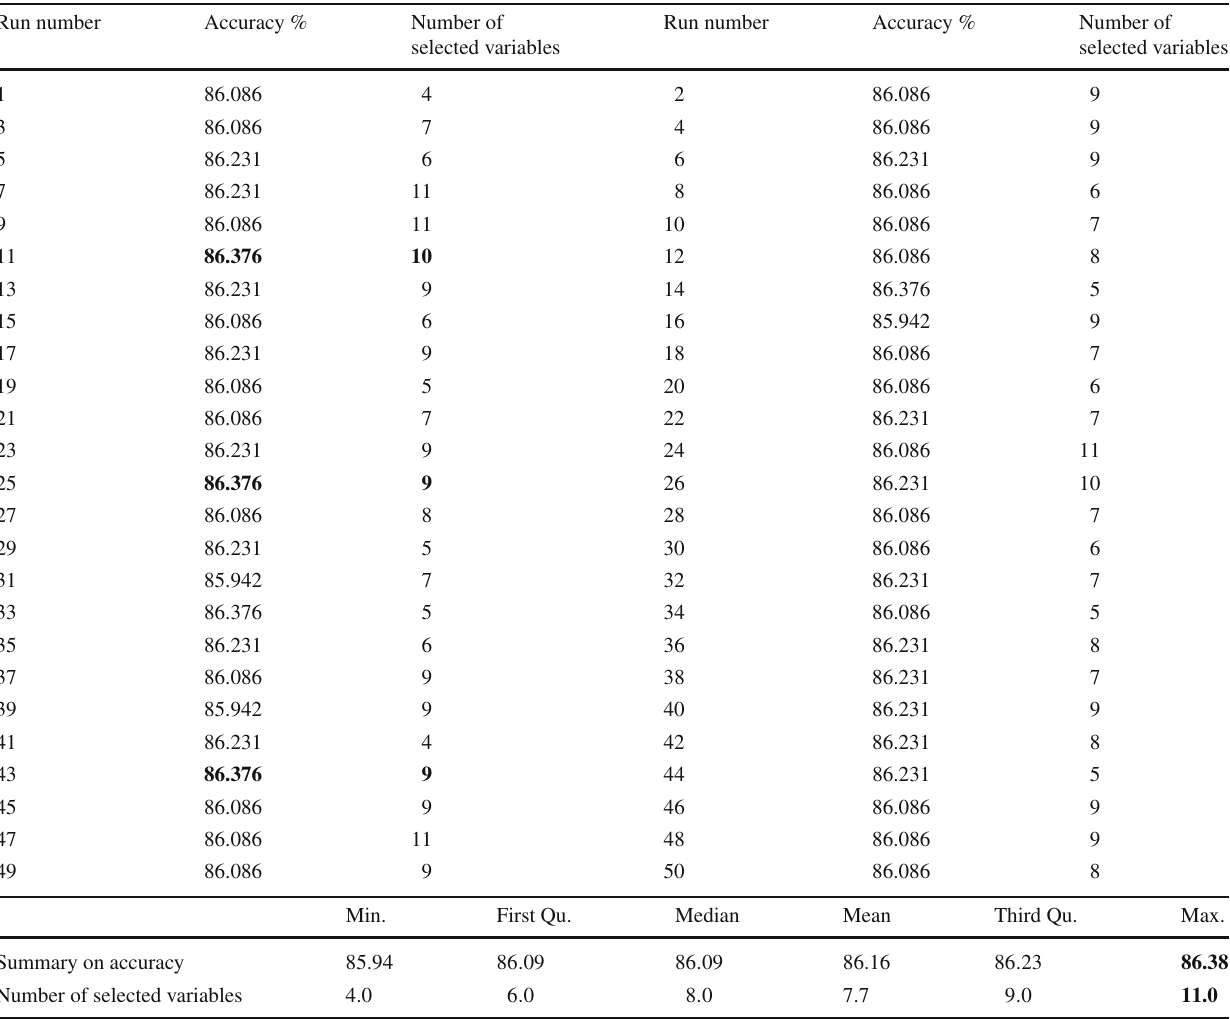
Table 6 The results of 50 run of SLS+SVM on Australian